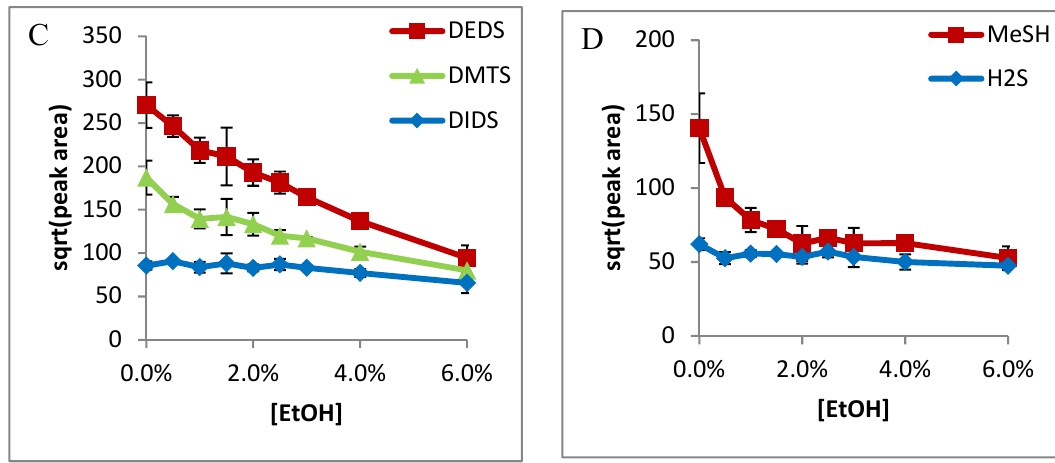
Figure 2. Effects of ethanol on the adsorption of DVB-Carboxen-PDMS SPME fiber of: ( A ) Internal standards EMS, MIS, DES, and EIS; ( B ) DMS, MeSOAc, DMDS, and EtSOAc; ( C ) large compounds DMTS, DEDS, and DIDS (IS); ( D ) highly-volatile compounds MeSH and H 2 S.